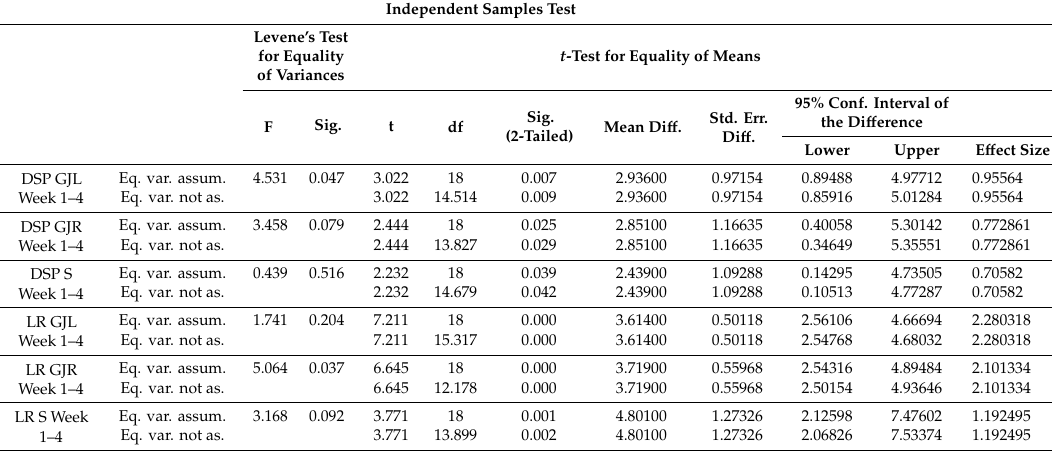
Table 10. Paired t -Test Results (CRITERIA = CI (0.9500)) of the Four-Week Training Period. DSP: dumbbell shoulder press, LR: lateral raise, S: spine, GJL: glenohumeral left joint, GJR: glenohumeral right joint, week 1–4: joint data of week 1 and week